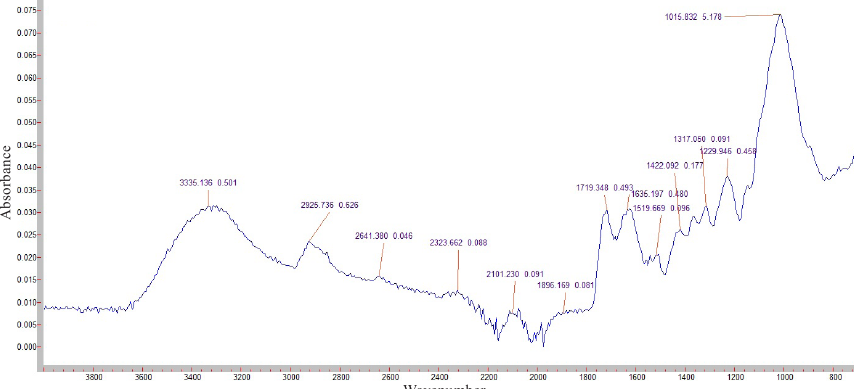
Figure 2 IR spectrum of a combined detoxicant obtained by extracting with succinic